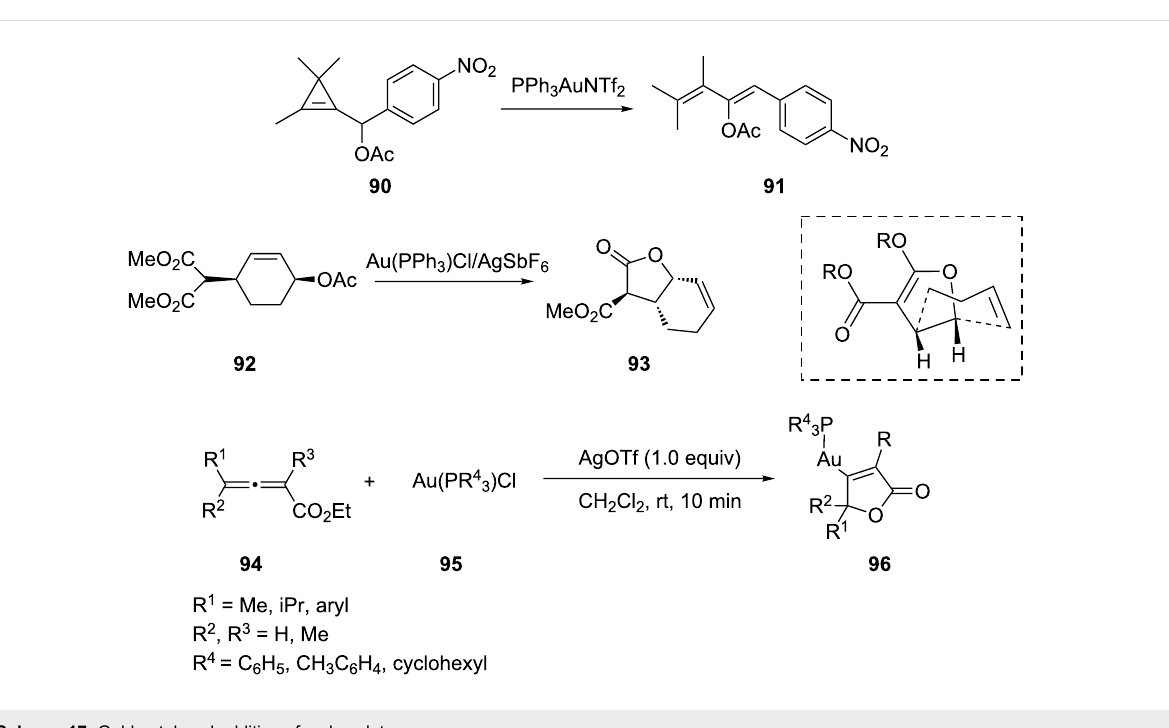
Scheme 17: Gold-catalyzed addition of